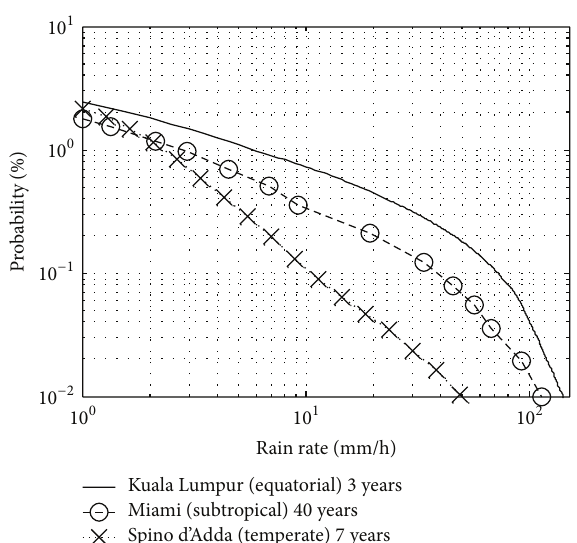
Figure 3: Comparison of monthly rainfall accumulation